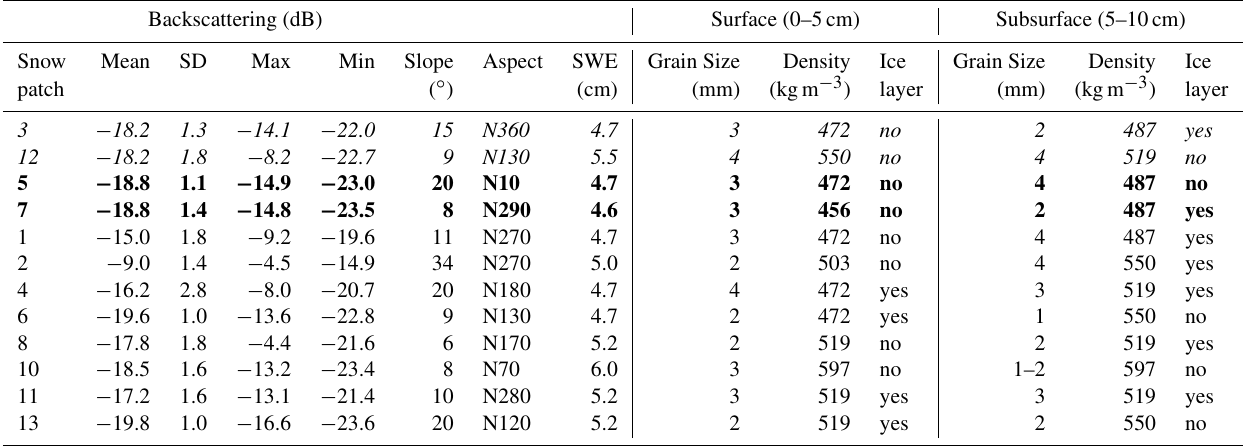
Figure 9. Radar backscattering of snow, water and soil ground-truthing areas for the three selected TerraSAR-X scenes: (a) HH polarization (12 January 2012), (b) VV polarization (13 January 2012) and (c) HH polarization (28 September 2012). Table 3. Snow-patch characteristics and backscattering in HH polarization (12 January 2012). Italics indicate the members of group 1 and bold indicates the members of group 2. All other snow patches are integrated into group 3.